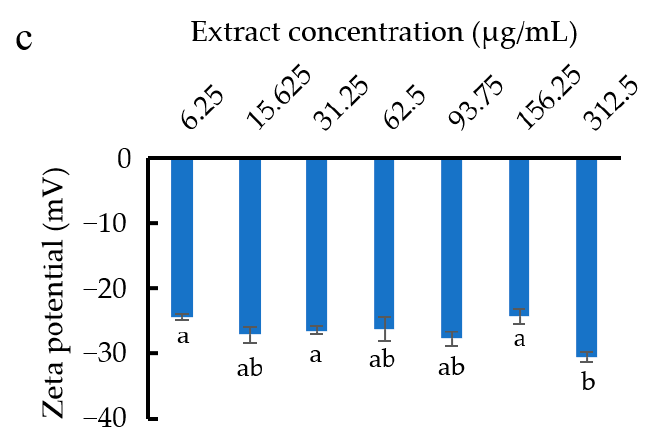
Figure 3. ( a ) Vesicle size, ( b ) size distribution, and ( c ) zeta potential of ethosomes loaded with dif- ferent concentrations of Z. zerumbet (L.) rhizome extract. Different letters above the error bars indi- cate significant differences at the 0.05 level (ANOVA and post hoc test).